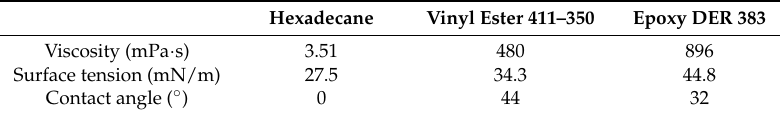
Table 2. Summary of fluids properties [18].